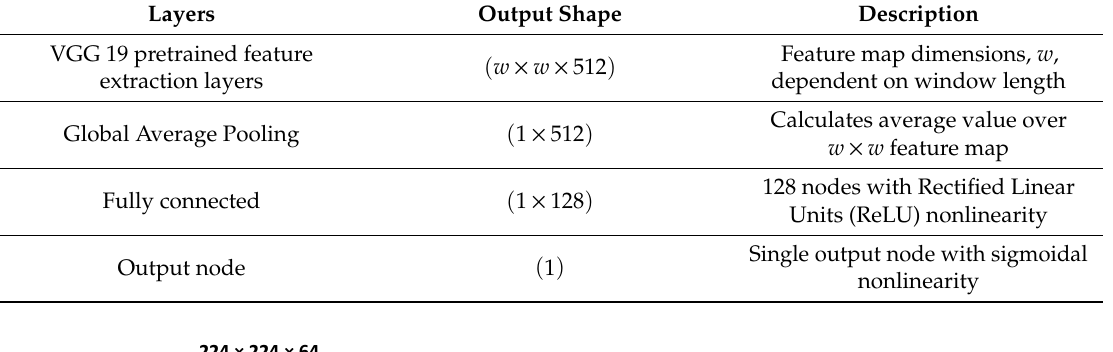
Table 1. Modified CNN architecture for contrast-based learning (Method II).